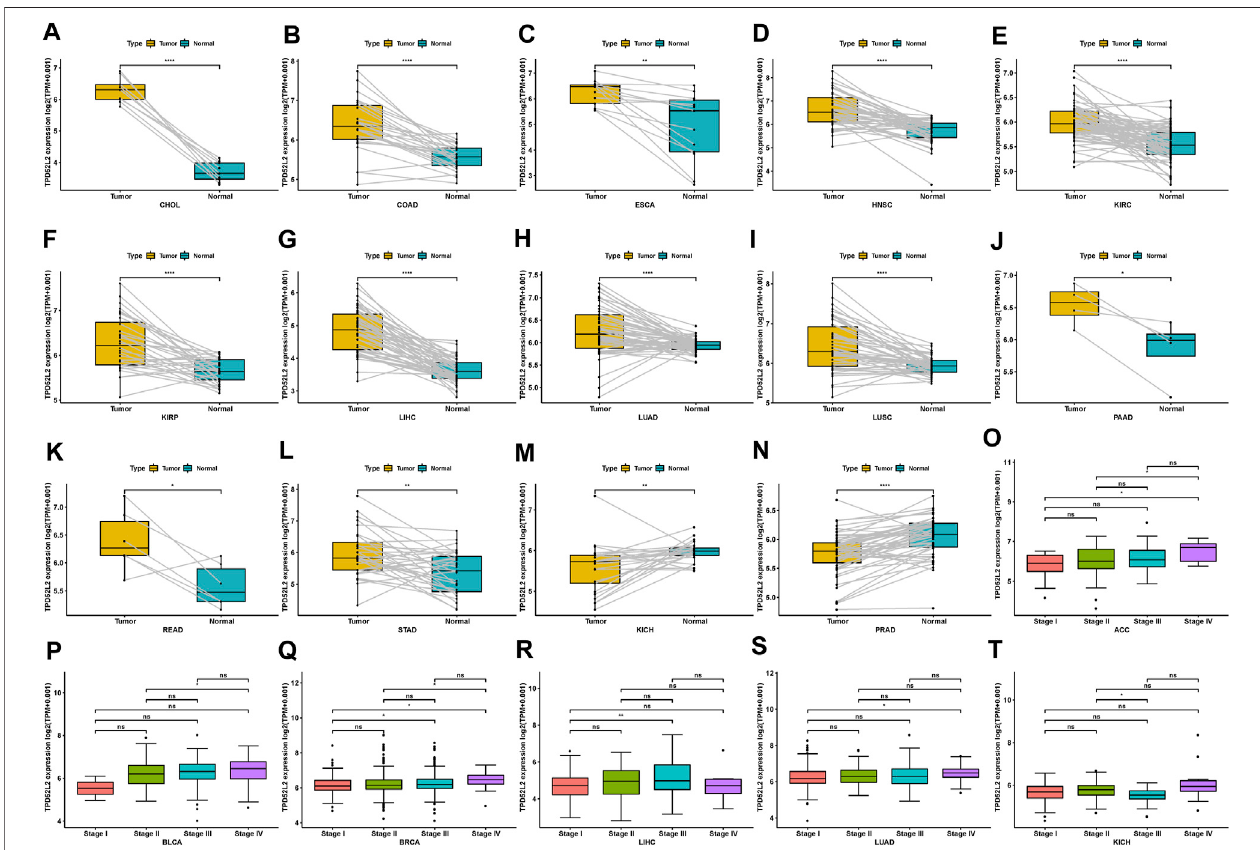
FIGURE 2 | Expression of TPD52L2 in paired tumor and adjacent normal tissues. (A – N) TPD52L2 expression in paired tumor and adjacent normal tissues from TCGA in indicated tumor types. (O – T) TPD52L2 expression in various tumor stages in indicated tumor types. * p < 0.05, ** p < 0.01, *** p < 0.001, and **** p < 0.0001.